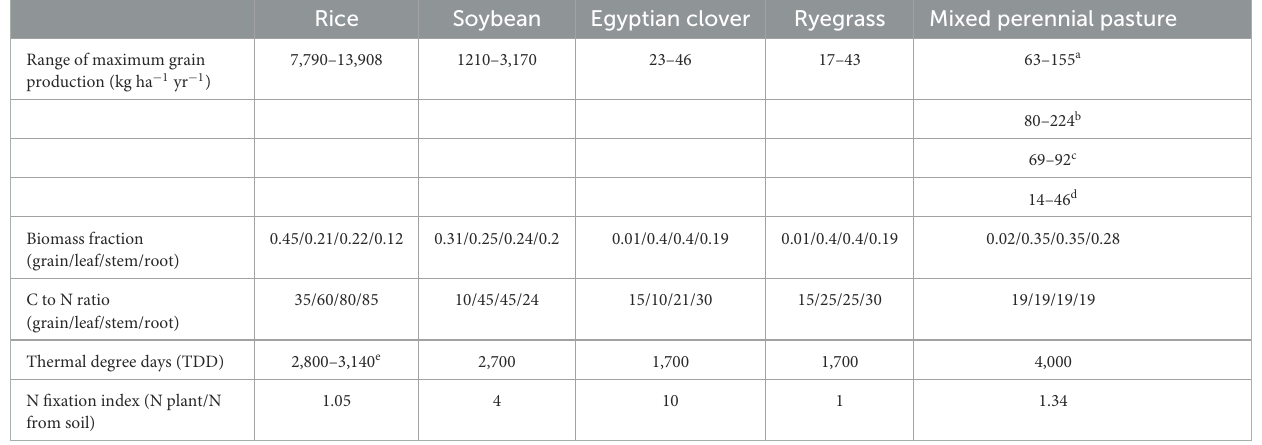
TABLE 2 DNDC cropping parameter settings used for calibration. Rice Soybean Egyptian clover